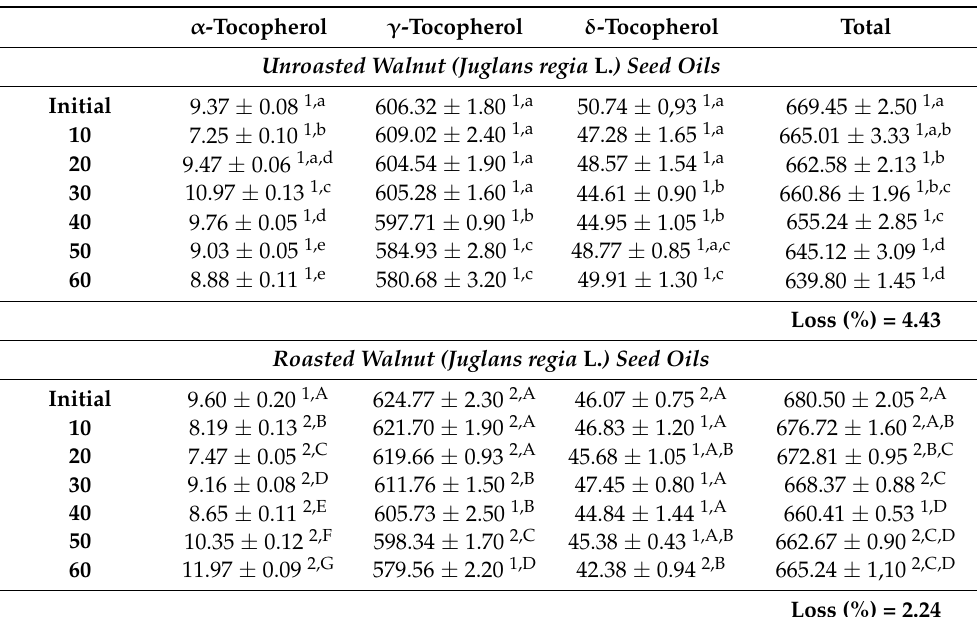
Table 2. The tocopherol composition (mg/kg) of UWO and RWO during 60 days of storage at 60 ± 2 ◦